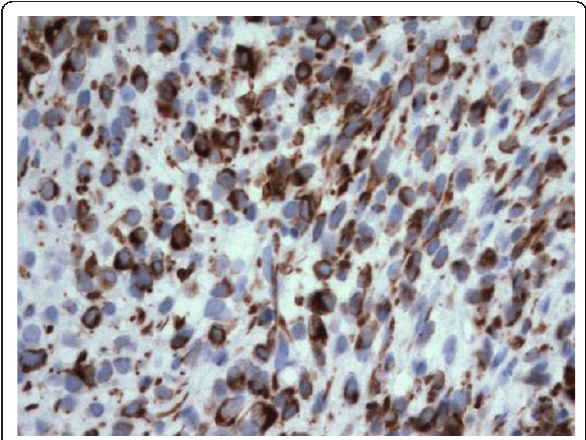
Figure 4 Microphotograph demonstrating cytoplasmic diffuse and punctate staining of malignant cells for desmin . [400